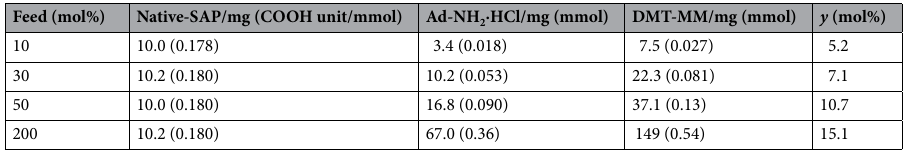
Table 2. Conditions and results of preparation of Ad( y )-SAP